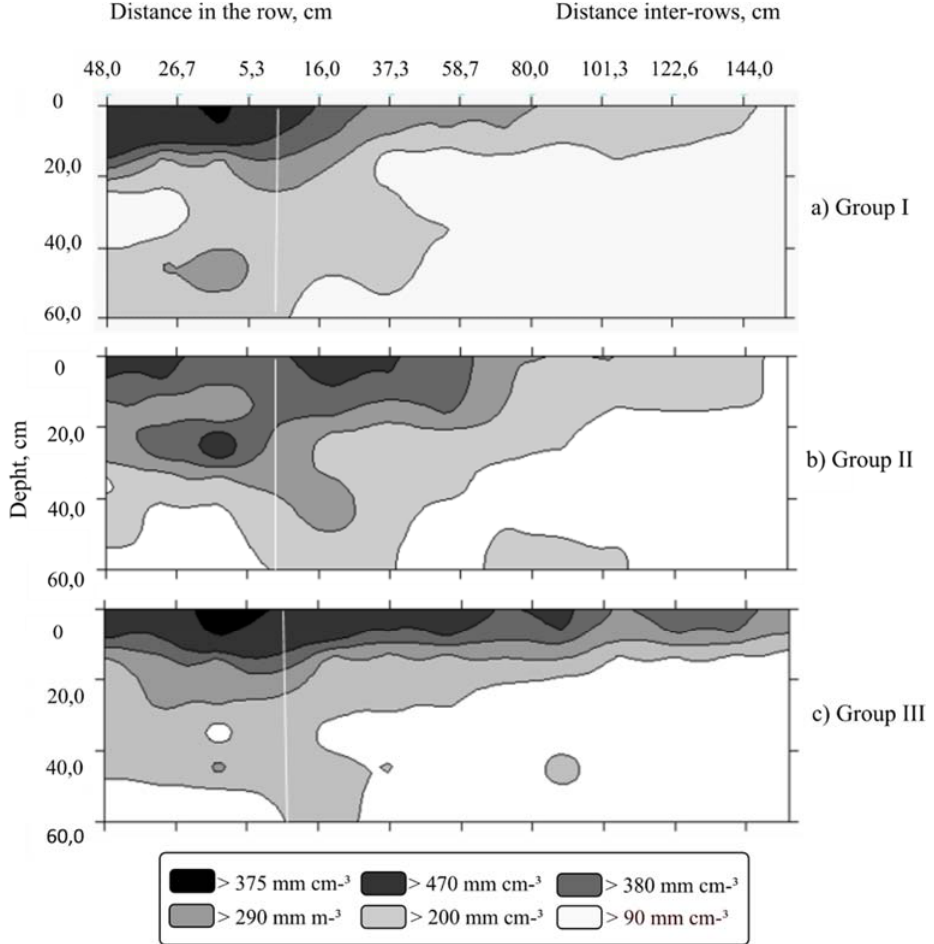
Figure 4. Spatial distribution map of roots in the soil profile for the length root density, based on the clustering of six C. canephora genotypes at three distances in the planting row (16, 32 and 48 cm) and nine distances in inter ‐ row planting (16, 32, 48, 64, 80, 96, 112, 128, 144 cm). Both distances were measured from the stem of the plant and six depths from the ground (0—10, 10—20, 20—30, 30—40, 40—50 and 50—60 cm) at each distance. The transverse white line refers the location of the plant. ( a ) Group I—AD1, Valcir P and Peneirão genotypes; ( b ) Group II—A1 and P2 genotypes and ( c ) Group III—Z21 genotype.